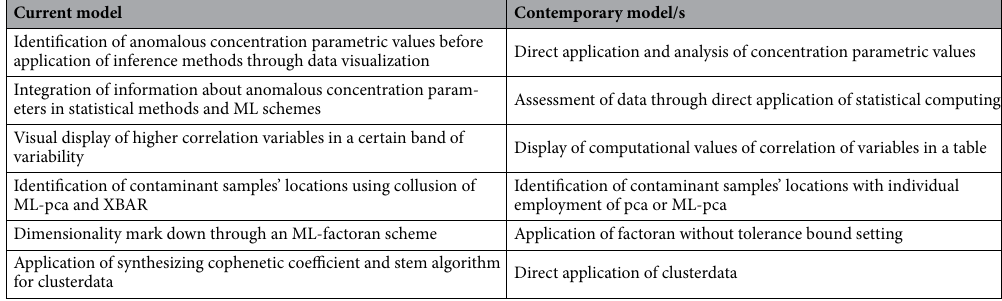
Table 12. Comparison of current schemes with literature